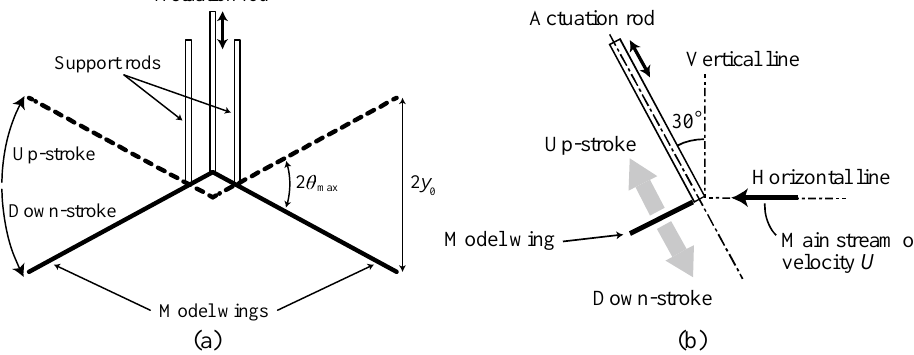
Fig. 2 Experimental mechanism of flapping of the model wing: (a)front view; (b)side